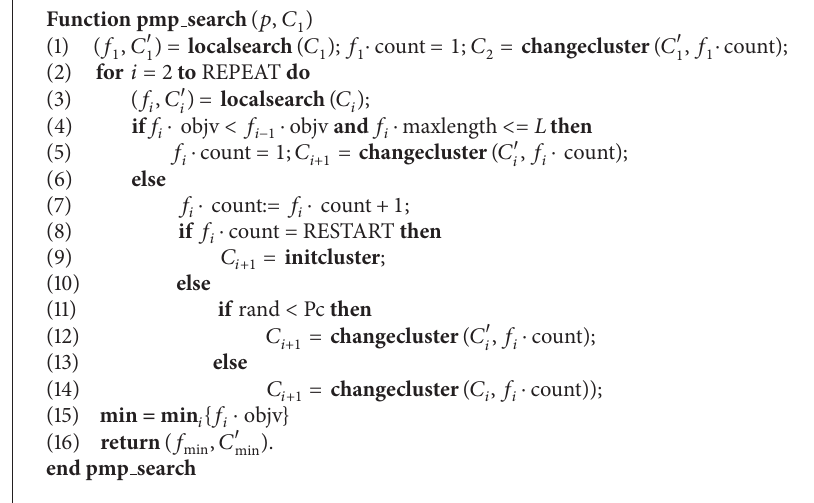
Algorithm 3: The modified VNS algorithm for the 𝑝 -median problem.